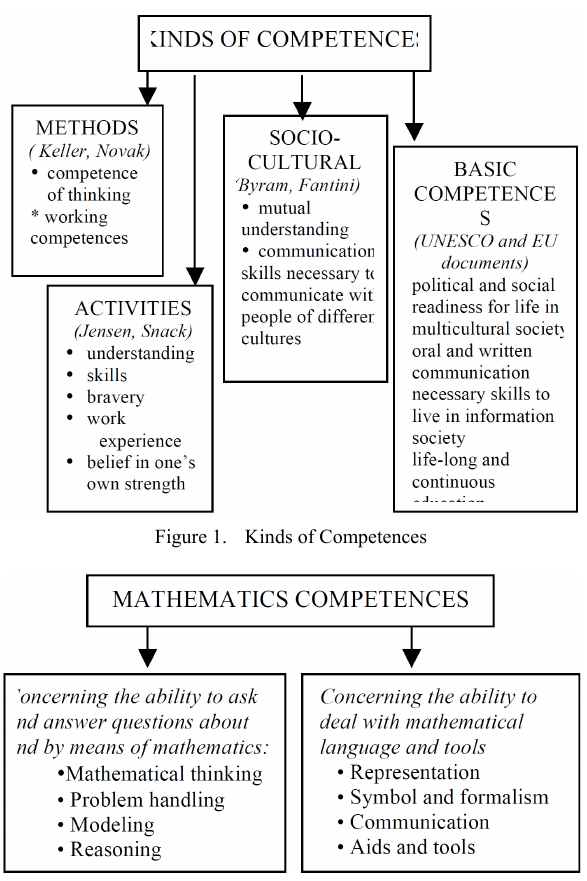
Figure 2. Mathematics